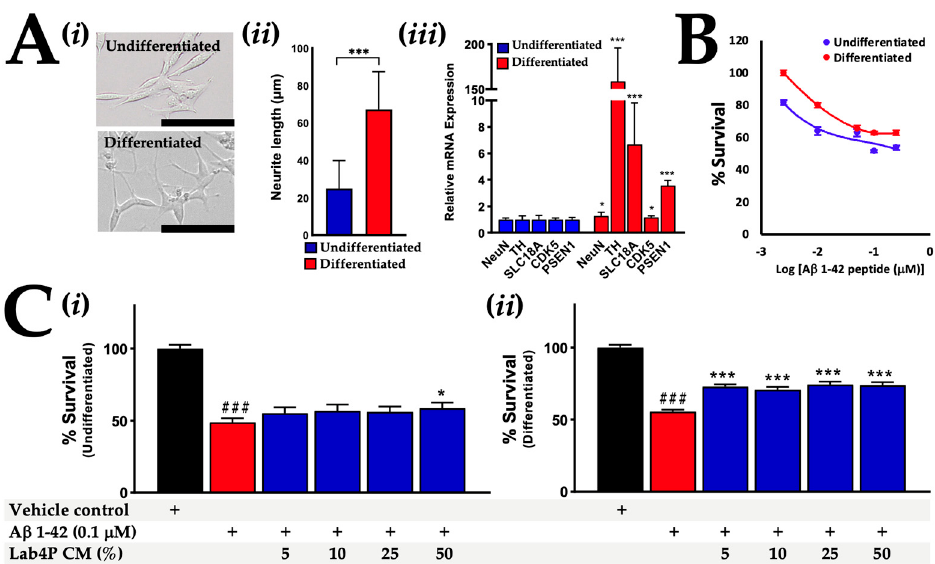
Figure 5. The impact of Lab4P CM on the survival of human SH-SY5Y neurons challenged with β -Amyloid 1-42. ( Ai ) Representative images (scale bar: 100 µ m), ( Aii ) neurite length and ( Aiii ) gene expression levels of neuronal and cholinergic markers in undifferentiated and RA/BDNF differentiated SH-SY5Y cells. ( B ) Non-linear regression analysis of the viability of undifferentiated and differentiated SH-SY5Y cells exposed to varying doses of β -Amyloid 1-42 peptides for 48 h. ( C ) The viability of ( Ci ) undifferentiated and ( Cii ) differentiated SH-SY5Y cells that were preincubated with DMEM/F12 or varying doses of Lab4P CM for 24 h prior to the addition of vehicle control (DMSO) or 0.1 µ M of β -Amyloid 1-42 peptides for 48 h. Black bar: DMSO control; Red bar: 0.1 µ M of β -Amyloid 1-42 alone; Blue bars: 0.1 µ M of β -Amyloid 1-42 with Lab4P CM. Gene expression data are expressed relative to undifferentiated cells that have been arbitrarily assigned as 1. Viability is expressed as percentage survival compared to the vehicle control that has been arbitrarily assigned as 100%. The data are presented as the mean ± standard error of the mean (SEM) of at least three independent experiments (with the exception of ( B ) which was a single experiment with quadruple replicates). Values of p were determined using students t -test ( Aiii ), Kruskal–Wallis test with Dunn’s post-hoc analysis ( Ci ) or one-way ANOVA with Tukey’s post hoc analysis ( Cii ) where * p < 0.05 or *** p < 0.001 versus undifferentiated cells ( Aii ) or β -Amyloid challenged cells (red bars, Ci , Cii ) and ### p < 0.001 versus the vehicle control (black bars, Ci , Cii ). Abbreviations: NeuN , neuronal nuclei antigen; TH , tyrosine hydroxylase; SLC18A , solute carrier family 18 member 2; CDK5 , Cyclin-dependent kinase; PSEN1 ,